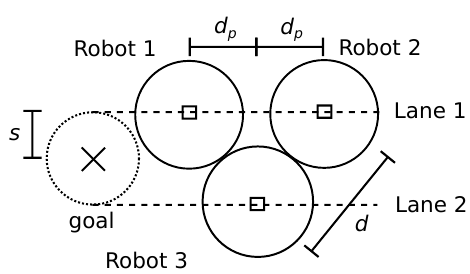
Figure 3. Two parallel robot lanes for a small target, illustrating the compact lanes